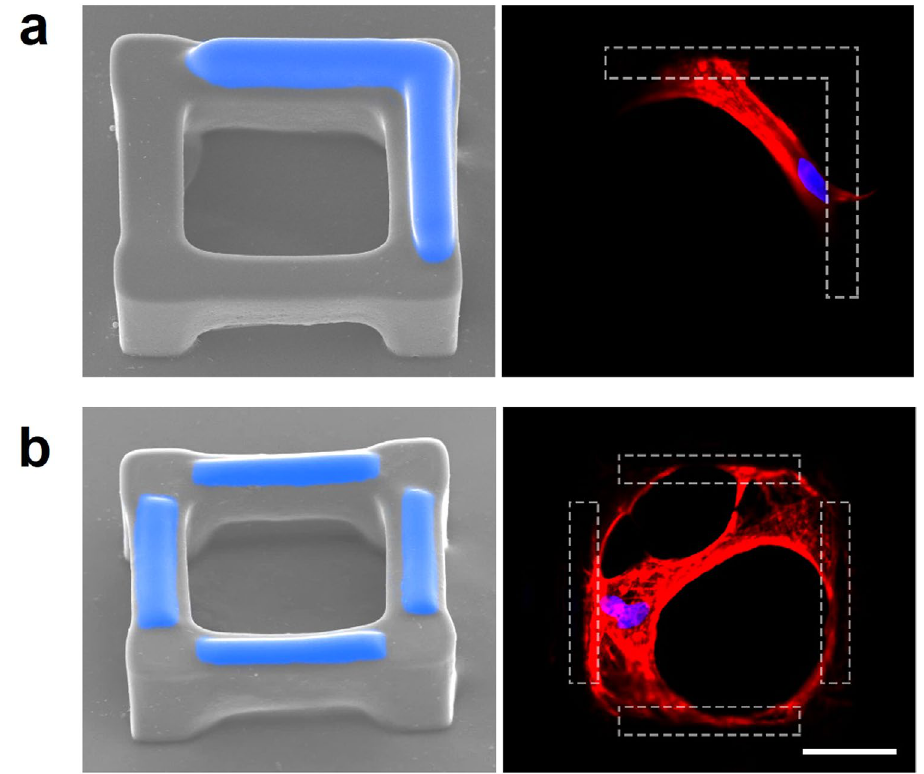
Figure 5. SEM images of the cubic microscaffolds with in-situ printed GelMA (highlighted in blue) and the fluorescent staining of f-actin (red) and nuclei (blue) of the hMSCs cultured in the corresponding microscaffolds (gelation shown as the dashed area). Scale bar = 50 μ